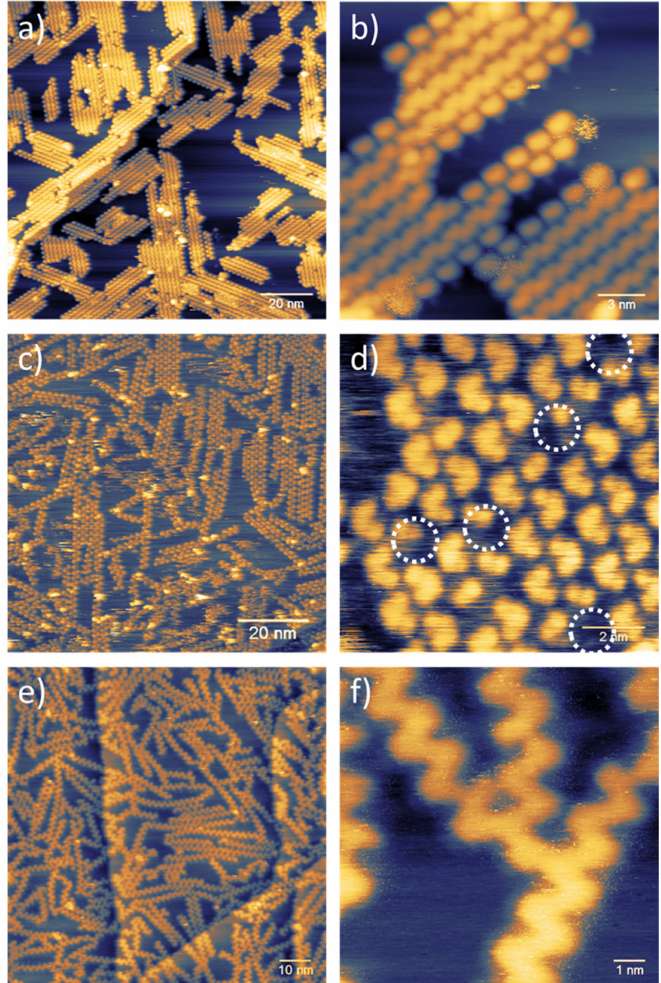
Figure 2. STM images of DITTP deposited onto I-Ag(111) via the RaDeS and annealed at increasing temperatures: ( a , b ) 200 ◦ C, ( c , d ) 400 ◦ C, and ( e , f ) 500 ◦ C. The changes in packing and STM appearance of the chains are in accordance with a gradually progressing reaction from ( a , b ) covalent polymers to ( e , f ) GNR. Image parameters: ( a ): 120 × 120 nm 2 , 90 pA, and 2.5 V; ( b ): 20 × 20 nm 2 , 90 pA, and 2.5 V; ( c ): 90 × 90 nm 2 , 88 pA, and 2.5 V; ( d ): 10 × 10 nm 2 , 85 pA, and 2.5 V; ( e ): 100 × 100 nm 2 , 92 pA, and 0.5 V; and ( f ): 10 × 10 nm 2 , 92 pA, and 0.1